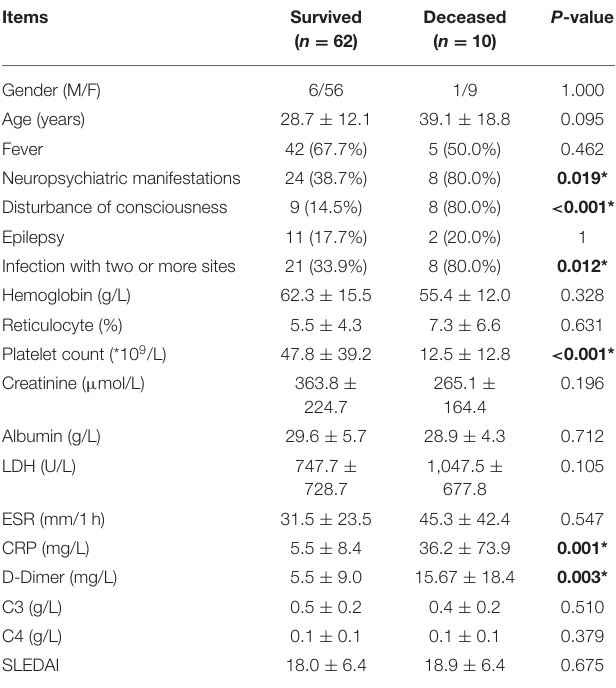
TABLE 3 | Risk factors for in-hospital mortality in patients with SLE with TMA. Items